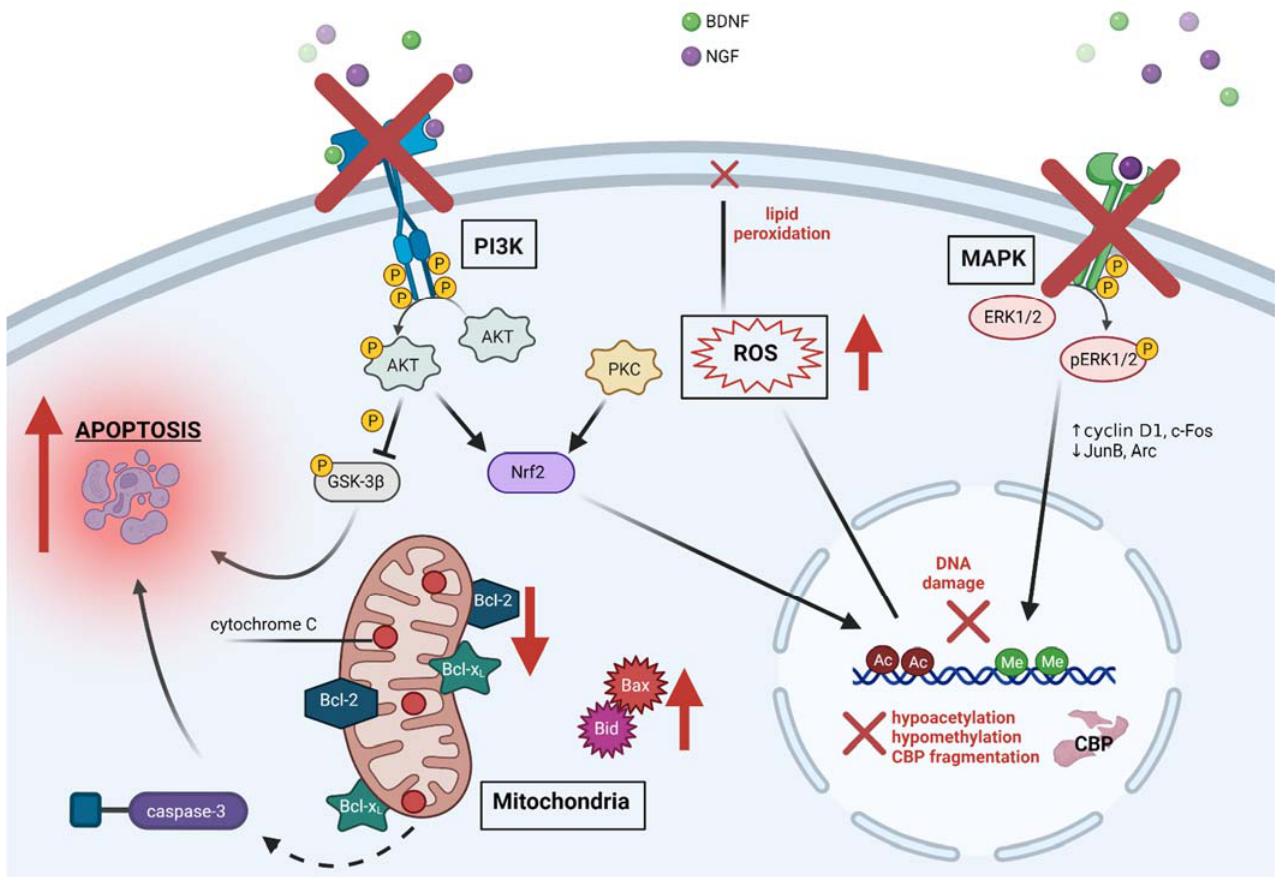
Figure 1. Summary of key cellular targets in the pathophysiology of anesthesia ‐ induced develop ‐ mental neurotoxicity. Red arrows and crosses represent the main events by which GAs exert their deleterious effects in immature neurons. GAs deprive neurons of survival signals initiated by growth factors, transduced by two major kinase pathways. Furthermore, GAs may directly induce ROS formation, genetic and epigenetic disturbances, and mitochondrial instability leading to cyto ‐ chrome c exudation and apoptosis. Black borders indicate neurotoxicity ‐ reversal points, triggered by neuroprotective strategies discussed previously. BDNF, brain ‐ derived neurotrophic factor; NGF, neural growth factor; PI3K, phosphatidylinositol 3 kinase; MAPK, mitogen ‐ activated protein kinase; PKC, protein kinase C; ERK, extracellular signal ‐ regulated kinase; GSK ‐ 3 β , glycogen synthase ki ‐ nase 3 beta; ROS, reactive oxygen species; Nrf2, nuclear factor E2 ‐ related factor 2; Ac, acetylated histones; Me, methylated DNA; CBP, CREB ‐ binding protein.